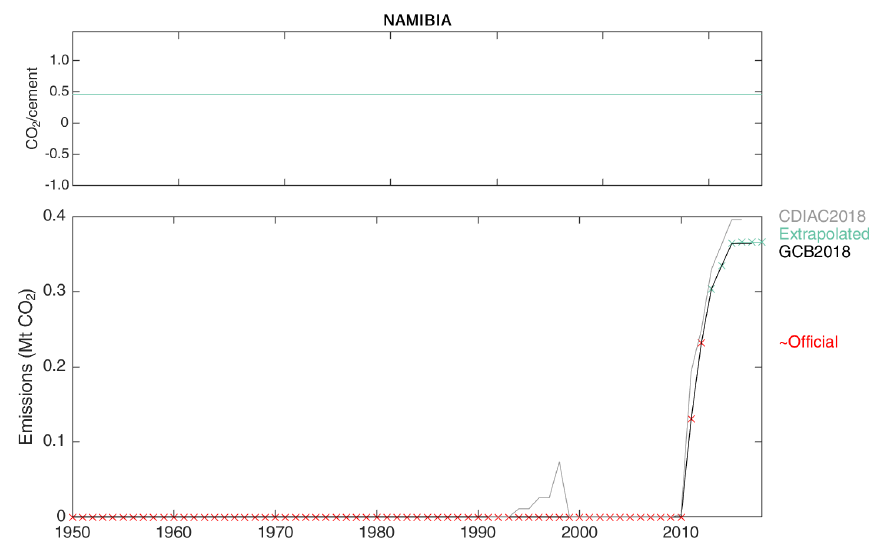
Figure C34. Revised cement emissions for